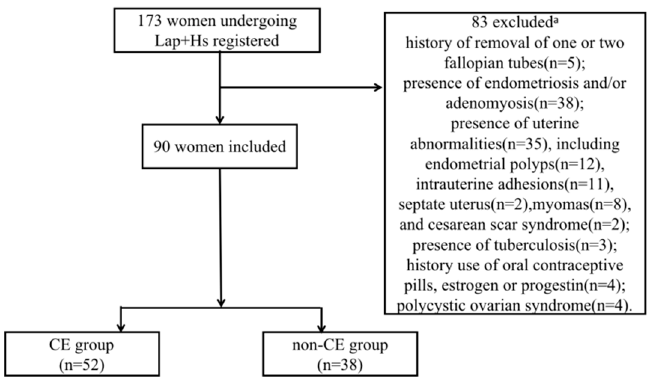
Figure 1. Data processing. a Some patients met more than 1 criterion for exclusion.